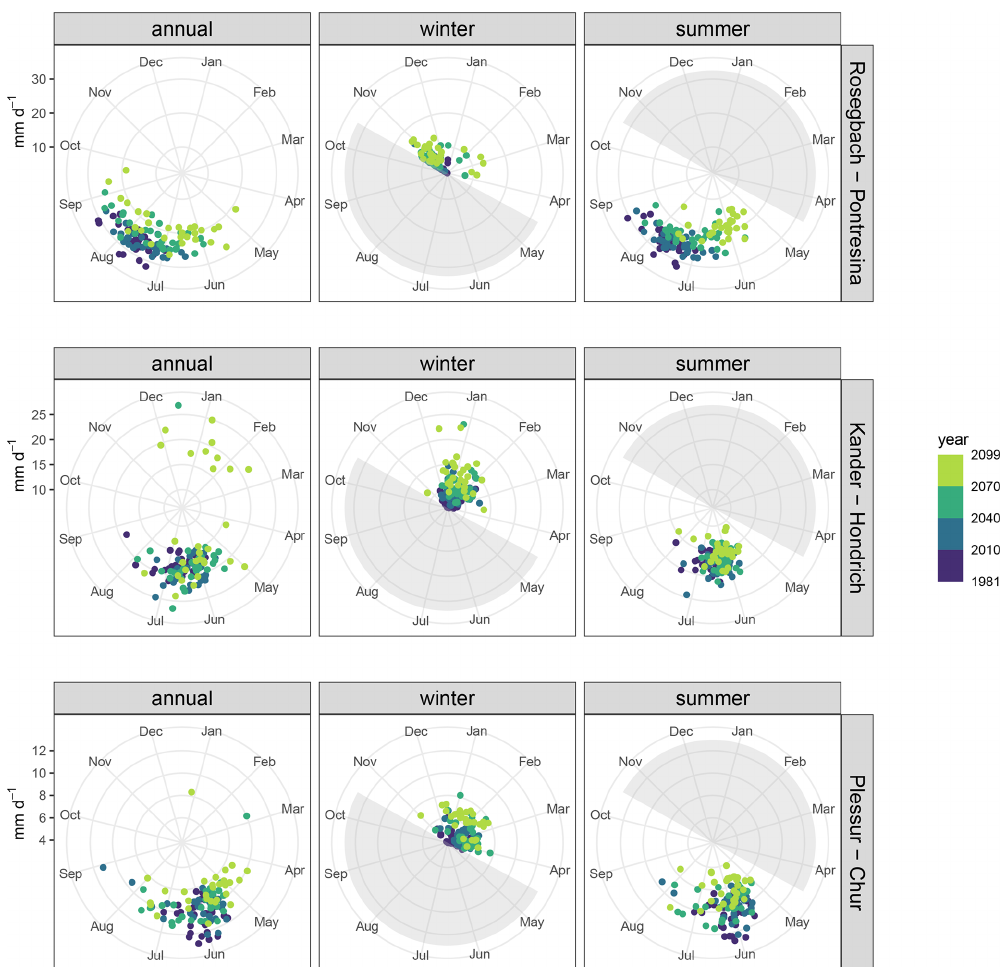
Figure 7. Multimodel median of magnitude and seasonality of high flows and seasonal high flows in Alpine catchments: Rosegbach (top row panels), Kander (middle row panels), and Plessur (bottom row